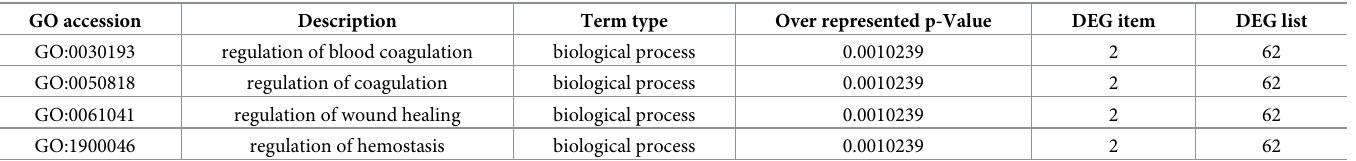
Table 3. Significantly Enriched GO terms in DEGs.